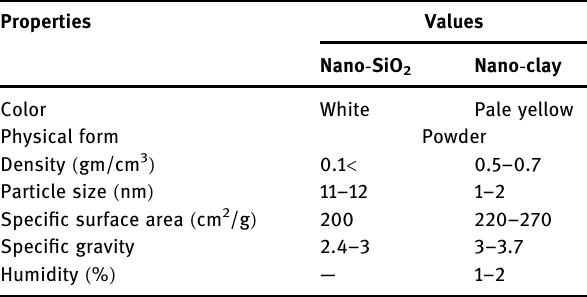
Table 1: Physical properties of nano - SiO 2 and nano - clay Properties